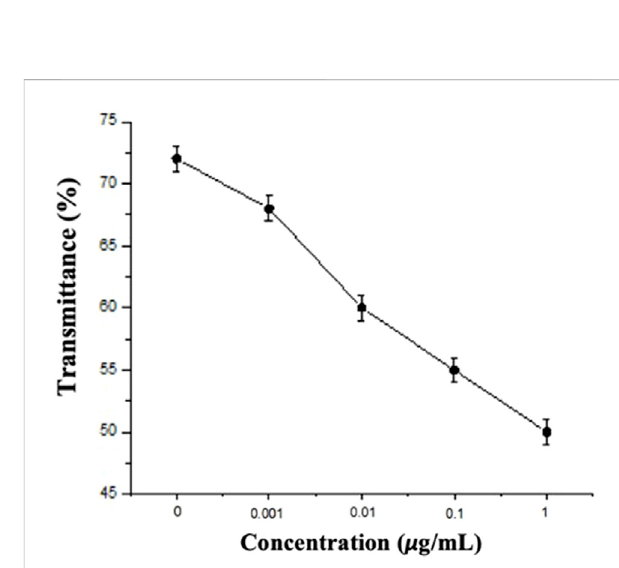
FIGURE 7 Folding line analysis of spike protein penetration spectra at different